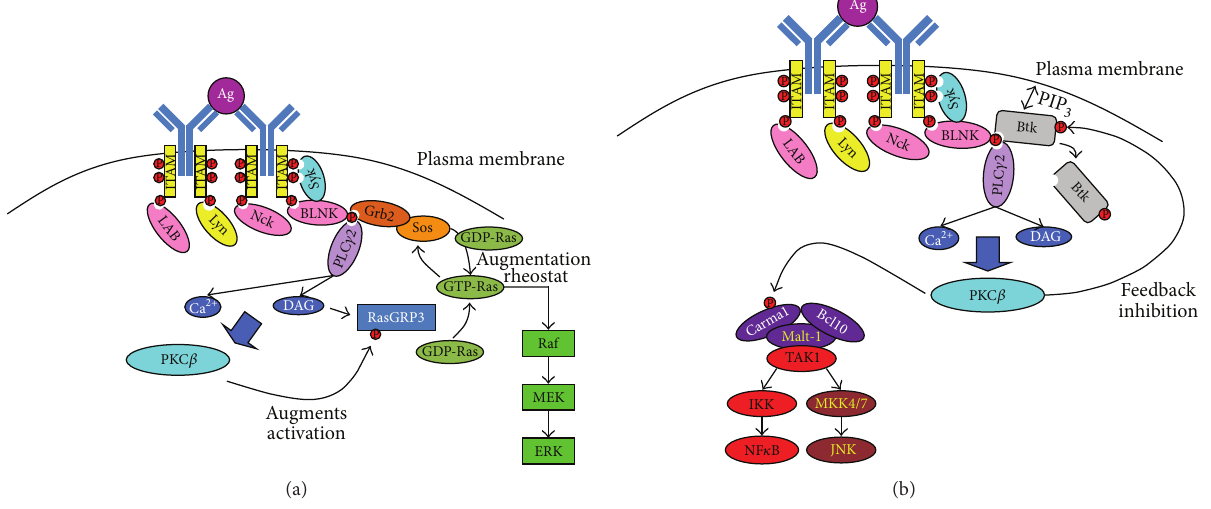
Figure 2: Signal integration following BCR engagement. Schematic of distal signaling events following BCR engagement. (a) Phospho-BLNK serves as a scaffold for Grb2, and this acts to prime activation of Sos. Active PKC 𝛽 phosphorylates RasGRP3 to facilitate its activation by DAG. The guanine exchange factor function of RasGRP3 converts GDP-Ras to GTP-Ras, which then acts to augment the guanine exchange factor function of Sos. Together RasGRP3 and Sos produce sufficient GTP-Ras to power activation of the MAPK cascade illustrated here by Raf, MEK, and ERK. (b) Active PKC 𝛽 acts to phosphorylate CARMA1 to induce assembly of the CARMA1-Bcl10-MALT1 complex. This allows activation of TAK1 which facilitates activation of the NF 𝜅 B pathway by phosphorylating IKK and of the JNK pathway by phosphorylating MKK4 and MKK7. Active PKC 𝛽 also acts in a feedback inhibition loop by phosphorylating Btk on serine 180. This catalyzes the removal of Btk from the plasma membrane away from its substrate, PLC 𝛾